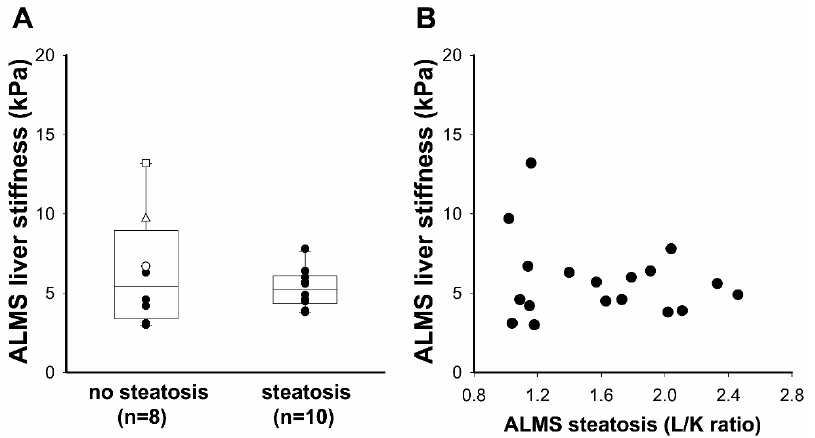
Figure 3. Relationships between liver stiffness and liver steatosis in patients with ALMS: ( A ) liver stiffness evaluated by the shear wave elastography in patients with ALMS divided into two subgroups on the basis of the L/K cut-off value (non-steatosis subgroup with L/K of <1.6 and steatosis subgroup with L/K of >1.6). Results were presented as a box plot, with 25 th and 75 th percentiles and median values. ID 1 (white triangle), ID 2 (white circle) and ID 5 (white square) patients had clinical signs of